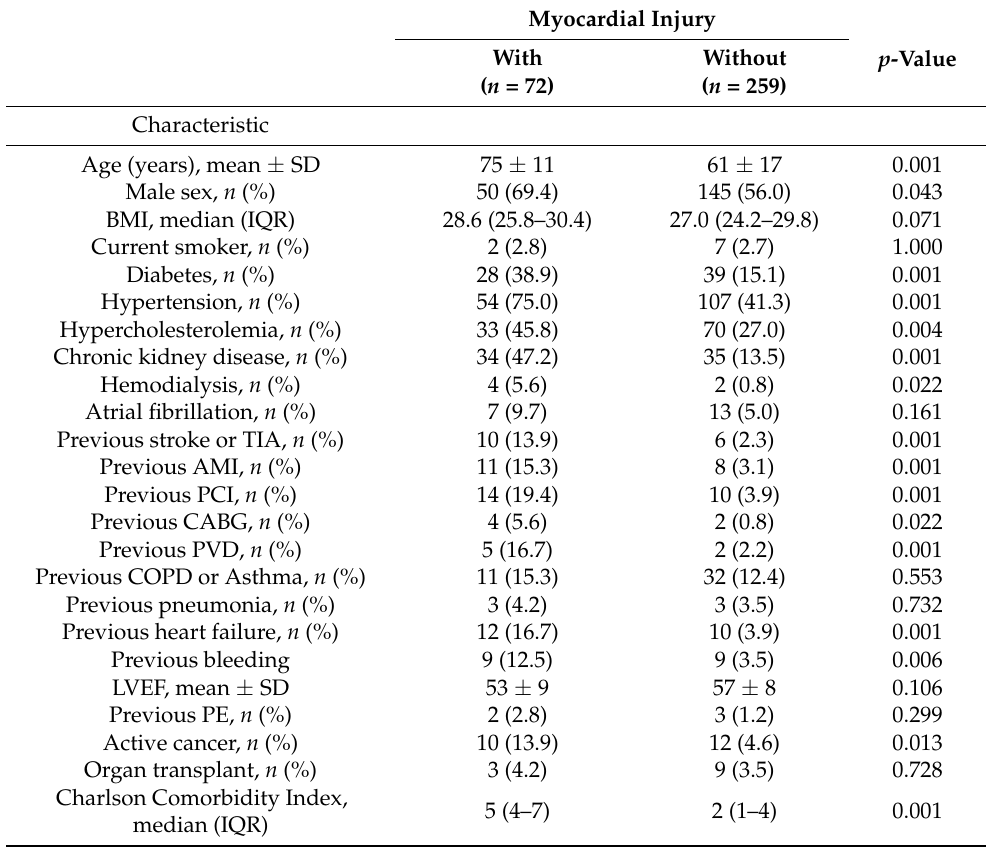
Figure 1. Flowchart of participant selection. Table 1. Baseline characteristics. In-hospital